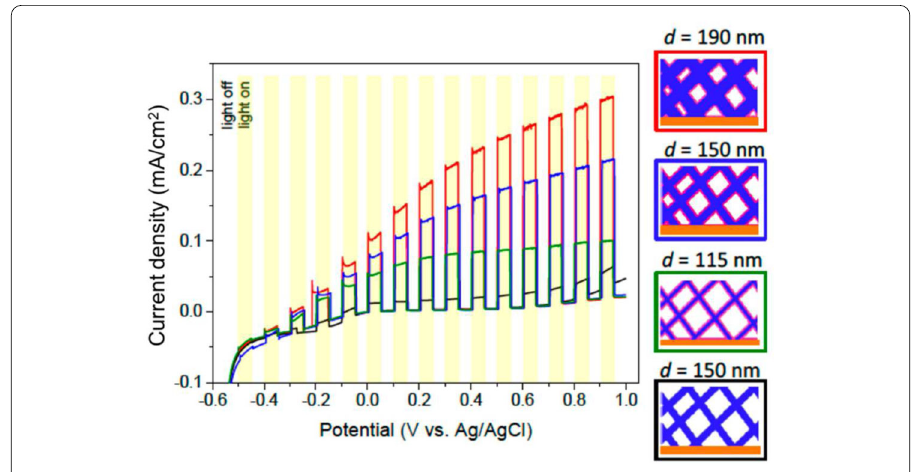
Figure 5 Photocurrents for uncoated and TiO 2 -coated ZnO nanowire networks with different wire diameters during a linear bias voltage sweep. Yellow and white areas correspond to illuminated or dark samples, respectively. From L. Movsesyan et al., ©Nanomaterials 8, 693